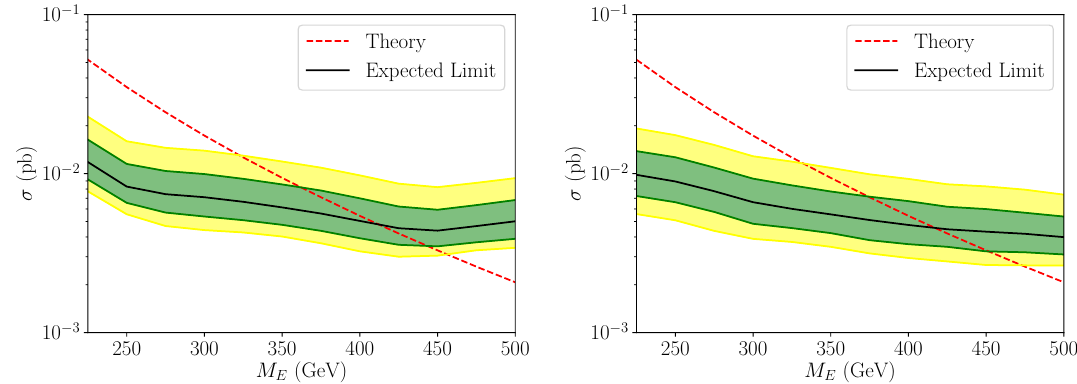
Figure 3 . Exclusion plot for a VLL singlet decaying into electrons (muons) on the left (right) panel √ at the LHC for s = 13 TeV and an integrated luminosity of 139 fb − 1 using the improved analysis. See text for